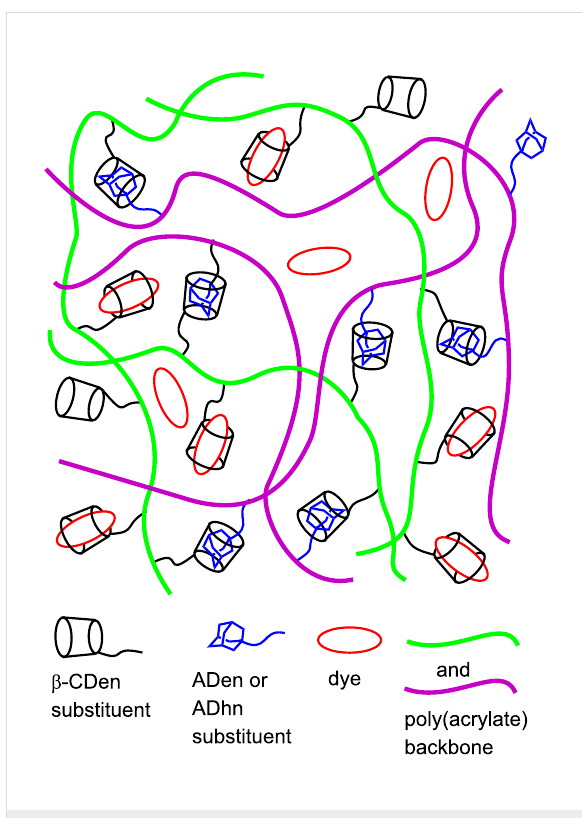
Figure 11: Representation of dye complexation in the PAA β -CDen/ PAAADen and PAA β -CDen/PAAADhn